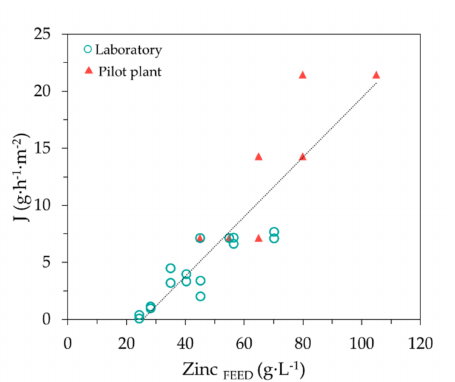
Figure 8. Zinc flux vs . zinc concentration in the feed phase. J EX and J BEX calculated from data of EXP III in this study ( (cid:78) ), and form bench scale data (